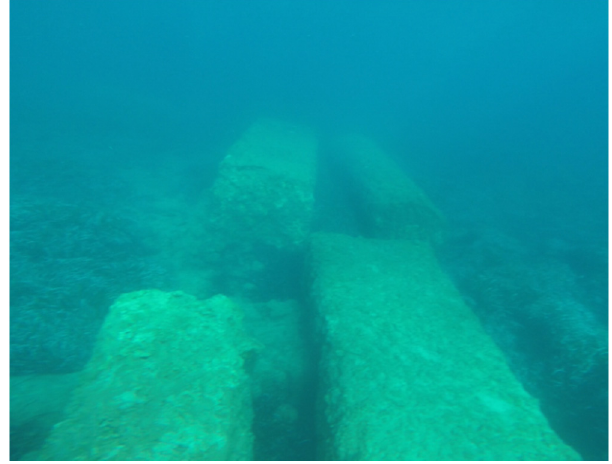
Figure 10. Aggregation of marble blocks and columns over wreck site 2.